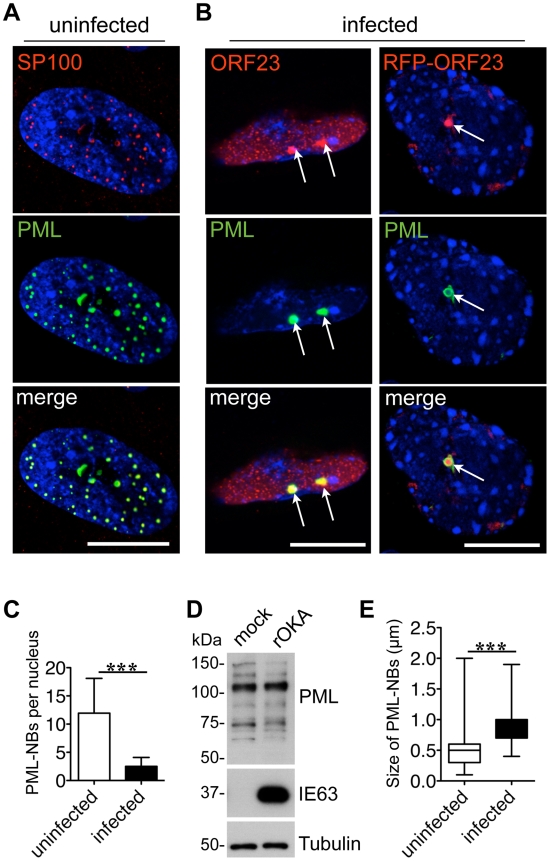
Endogenous PML-NBs colocalize with ORF23 capsid protein in VZV infected cells.(A) Uninfected human embryonic lung fibroblasts (HELF) were immunostained for SP100 (red) or PML (green) to visualize PML nuclear bodies (PML-NBs). Nuclei were stained with Hoechst (blue). (B) HELF cells were infected with cell-associated VZV for 24 hr and immunostained for PML (green) and ORF23 (red). PML-NBs and ORF23 capsid protein colocalized (white arrows) in HELF infected with either VZV (left panel) or VZV expressing red fluorescent protein (RFP)-tagged ORF23 (right panel). Nuclei were stained with Hoechst (blue). ORF23 capsid protein was identified in 94% (N = 228) of PML-NBs that were present in VZV infected cells at 24 hr. Scale bars in A and B are 5 µm. (C) Quantitation of the mean number of PML-NBs in nuclei of uninfected HELF (N = 180) and in infected HELF cells at 48 hr after infection (N = 180). The graph shows the mean ± SD; asterisks indicate a significant difference (p<0.0001). (D) Immunoblot analysis of PML protein (upper panel), VZV IE63 protein as a marker of VZV infection (middle panel) and tubulin (lower panel) in whole cell lysates of HELF that were mock-infected or infected with VZV (rOka) for 48 hr. (E) Quantitation of the mean size (diameter in µm) of PML-NBs in uninfected HELF and infected HELF. The box and whiskers plot shows the mean, 25 and 75 percentiles and the range of PML-NB sizes from 100 uninfected or infected nuclei, respectively; asterisks indicate a significant difference (p<0.0001).